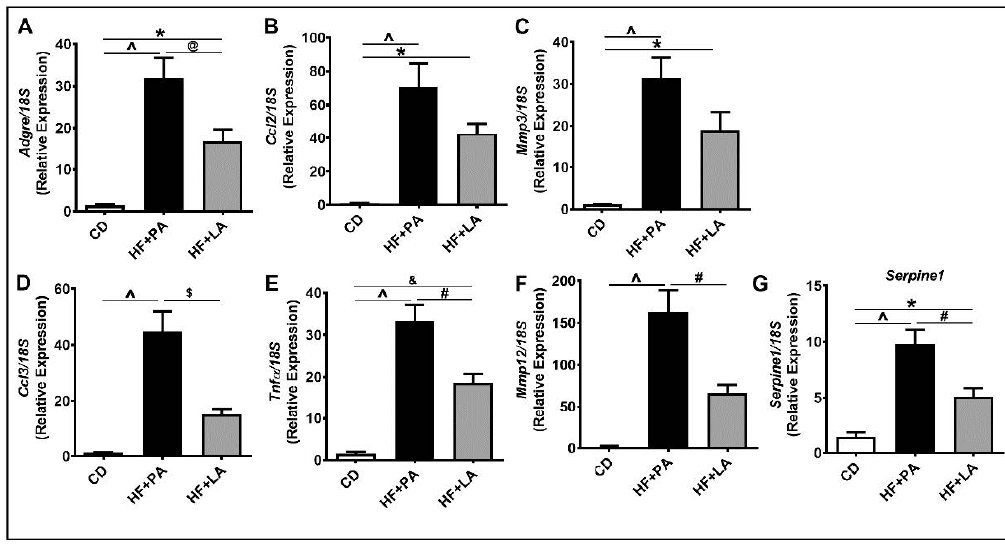
Figure 2. Effect of HF diet supplemented with PA or LA on VAT inflammation. Immunohistochemistry was performed to detect MCP-1 in the visceral adipose tissue (VAT) sections from CD ( A ), HF + PA ( B ), and HF + LA-fed mice ( C ). Representative images at 20× magnification are shown. The intensity of MCP-1 staining was quantified ( D ). Immunofluorescence analysis was performed to detect IL-6 in VAT sections from CD ( E ), HF + PA ( F ), and HF + LA-fed mice ( G ). The intensity of IL-6 staining was quantified ( H ). Values are expressed as mean ± SEM of 4–6 samples in each group. * p < 0.05 versus CD. MCP-1, monocyte chemoattractant protein-1; IL-6, interleukin-6; CD, chow diet; HF + PA, high fat + palmitic acid; HF + LA, high fat + lauric acid.